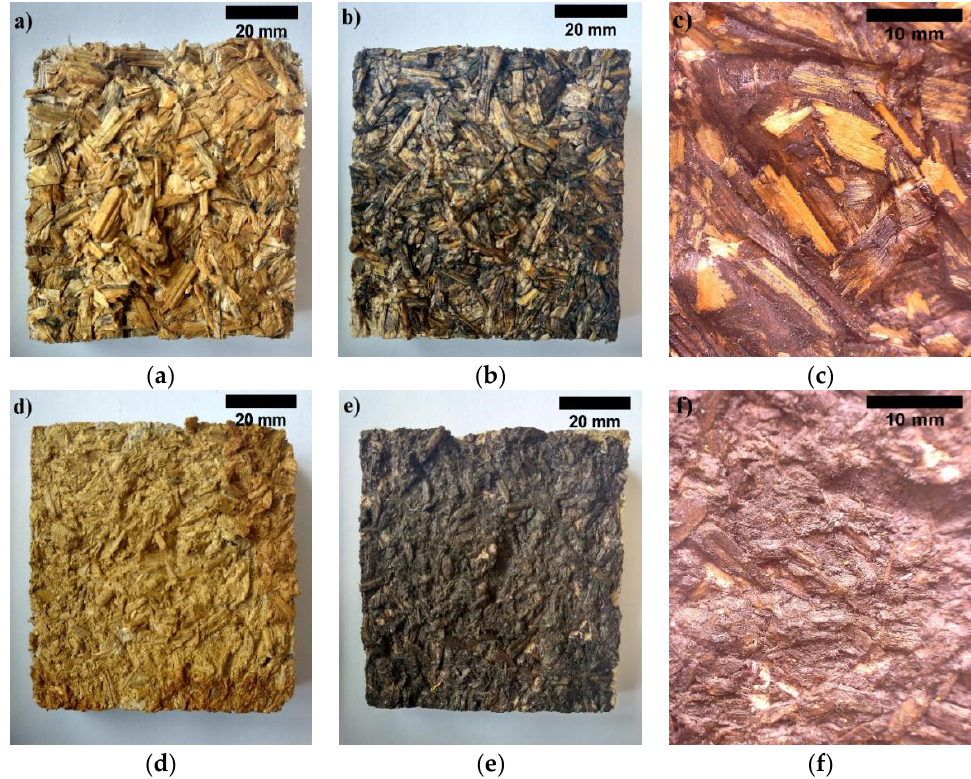
Figure 12. View after tensile test when the BcB are obtained from (magnification ×10): ( a ) non-shredded HS without CS; ( b ) non-shredded HS and 10 wt.% of CS; ( c ) non-shredded HS and 10 wt.% of CS (magnification ×10) ( d ) shredded HS without CS; ( e ) shredded HS with 10 wt.% of CS; ( f ) shredded HS and 10 wt.% of CS.